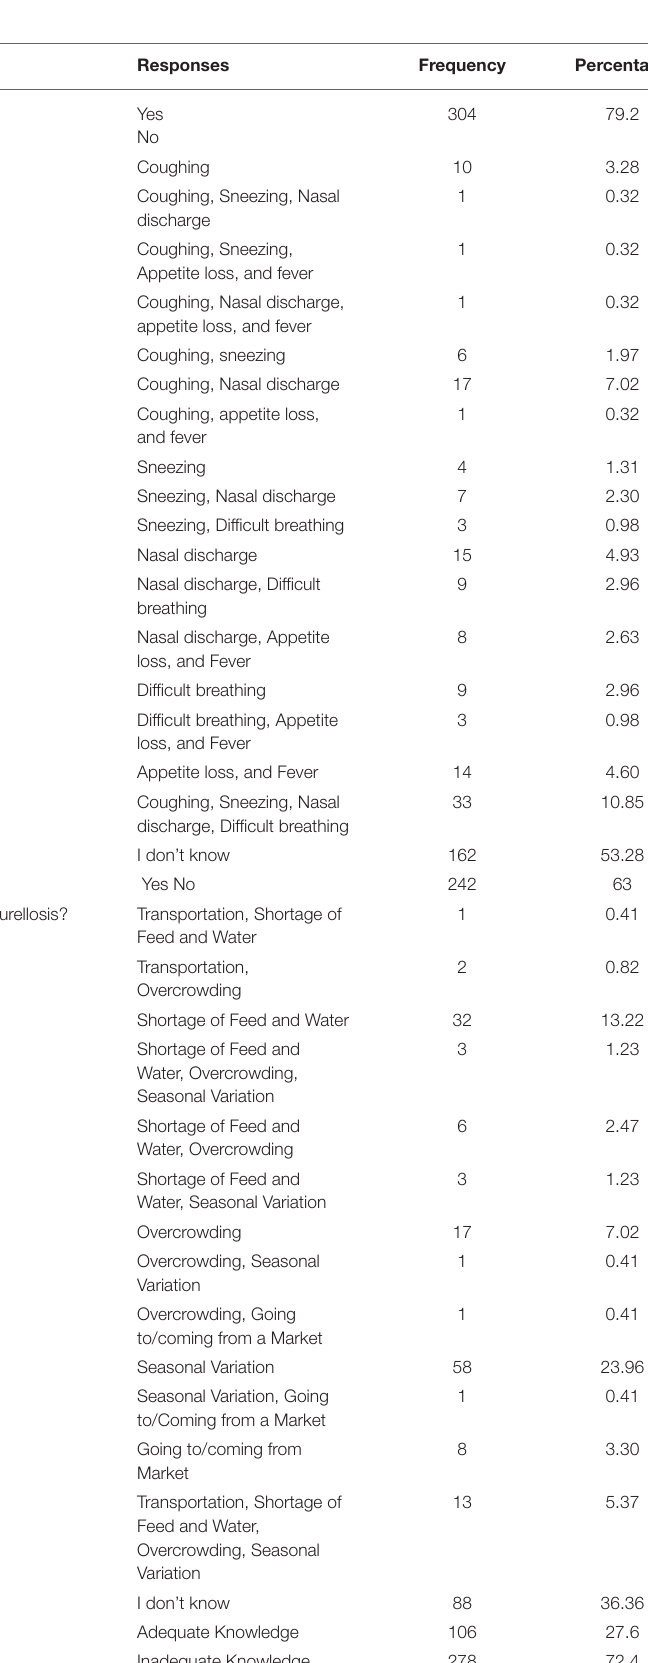
TABLE 1 | Respondents’ knowledge level on ovine pasteurellosis ( n =